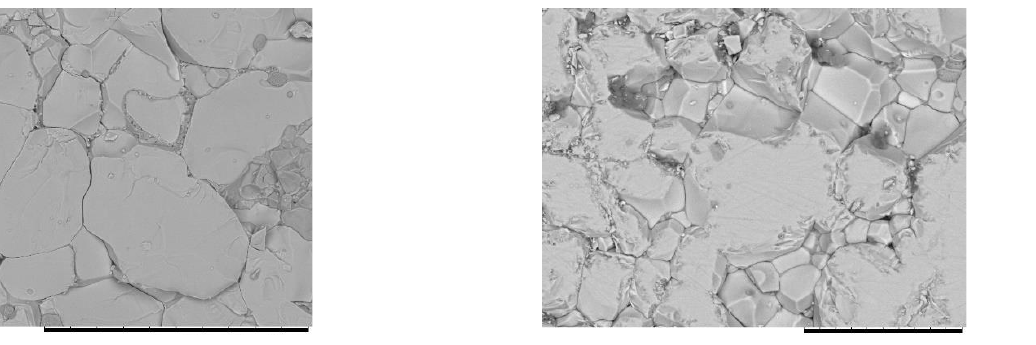
Figure 1. Scanning electron microscopy (SEM) images of the fractured surface of the as-synthesized Sm 2 CuMn(MnTi 3 )O 12 sample. The scale bars are 100 µm ( left ) and 30 µm ( right ); magnification is 1000 ( left ) and 2000 ( right ). The surface is partially polished in the right panel. No polishing has been done in the left panel.